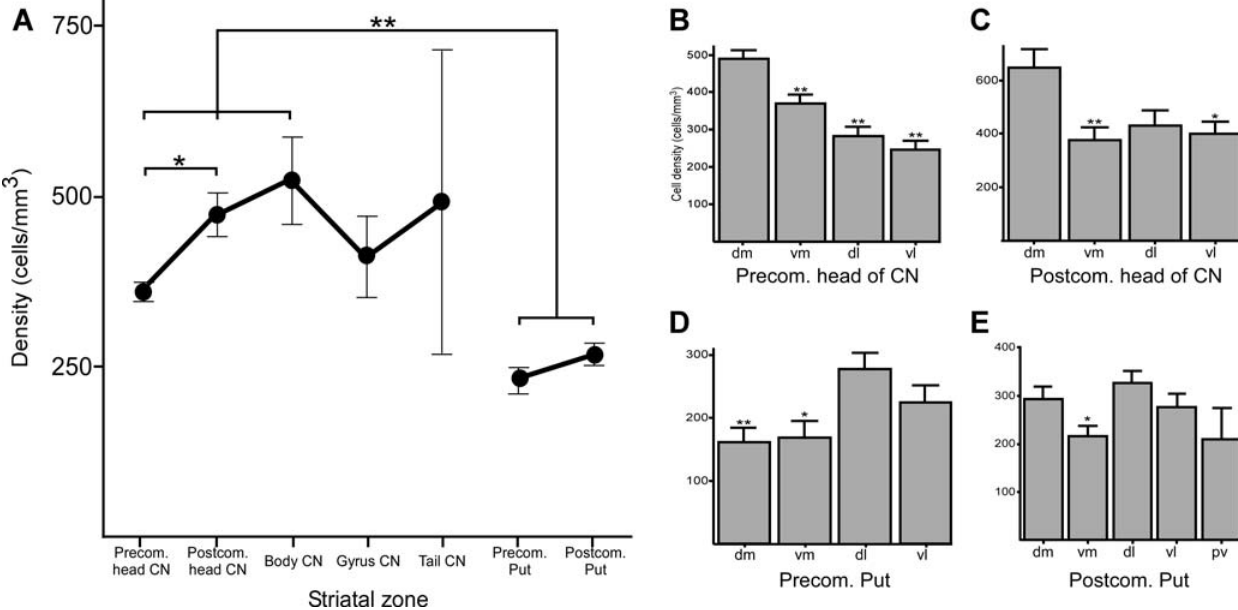
Figure 2. Variation in the density of the cholinergic interneurons throughout the striatum. A , line graph showing the mean density of the cholinergic neurons (cells/mm 3 ) in the various striatal territories of the CN and Put. B–E , bar graphs illustrating the mean density of cholinergic cells in the various sectors (i.e. dm, vm, dl, vl) of the following striatal territories: CN precommissural head ( B ), CN postcommissural head ( C ), precommissural Put ( D ) and postcommissural Put ( E ). Significant (*, 0.05 . P . 0.01) and highly significant (**, P , 0.01) differences are indicated. dl, dorsolateral; dm, dorsomedial; pv, posteroventral; vl, ventrolateral; vm, ventromedial.